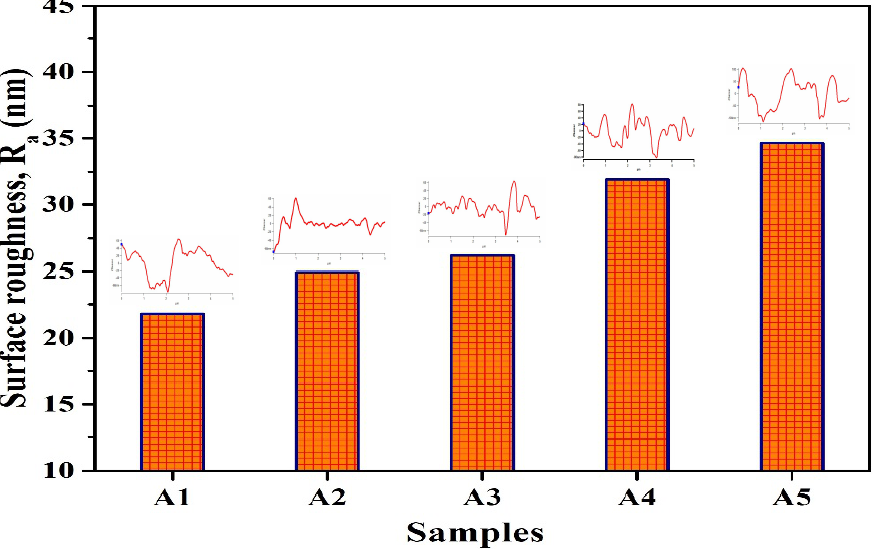
Figure 7. Surface roughness (Ra) data for AFM images of the developed Al/SiC/TiO 2 hybrid nanocomposites with their X profiles.